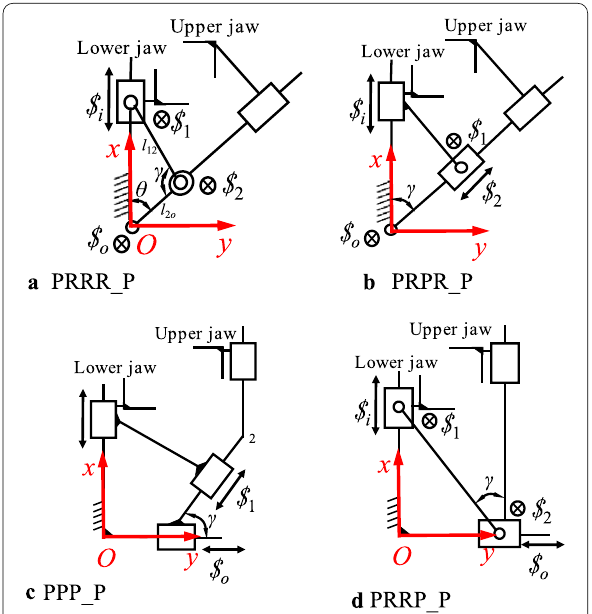
Figure 6 Optional structure of grasping module